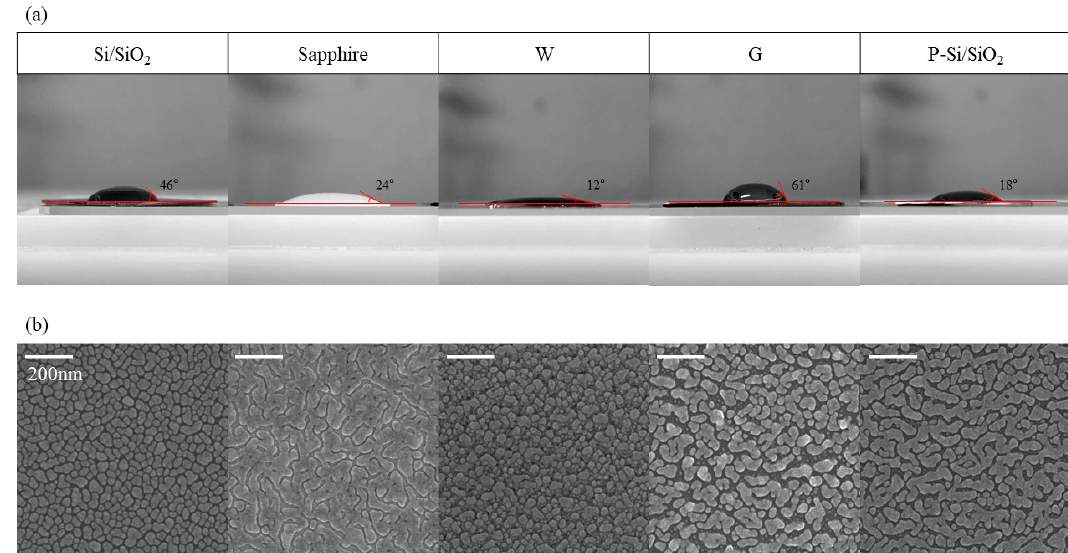
Figure 5. Wettability of each substrate. 30 nm of Ag was deposited at 2.4 Å/s on a different substrate. ( a ) Contact angle images of each substrate. ( b ) SEM images of 30 nm Ag deposited with oblique angle deposition on different substrates.